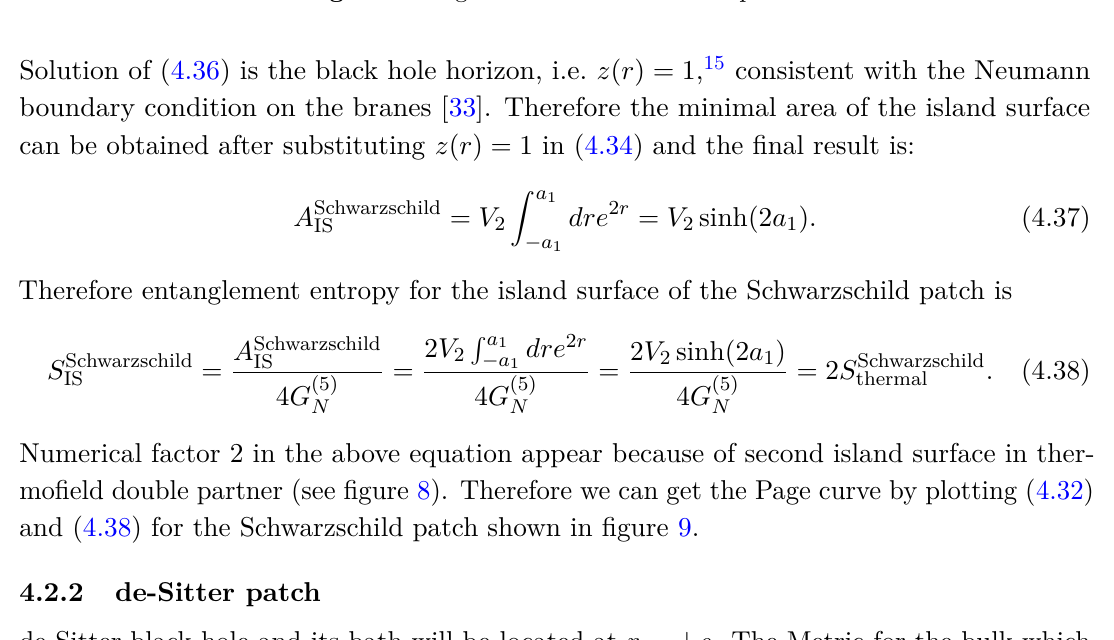
Figure 9 . Page curve of Schwarzschild